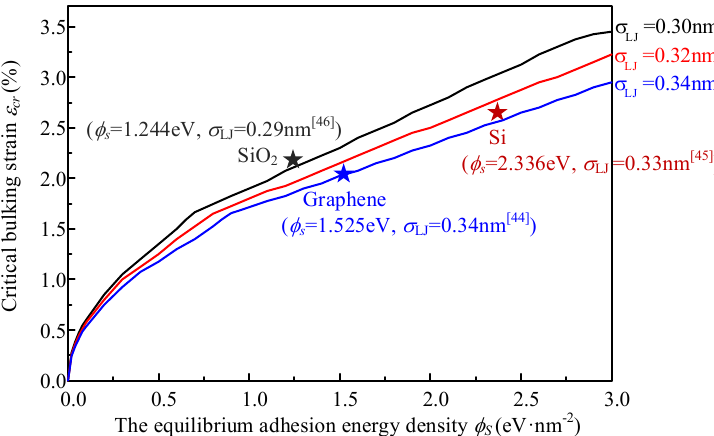
Figure 9. The effect of substrate adhesion on the critical buckling strain. The typical substrate materials are marked by stars.